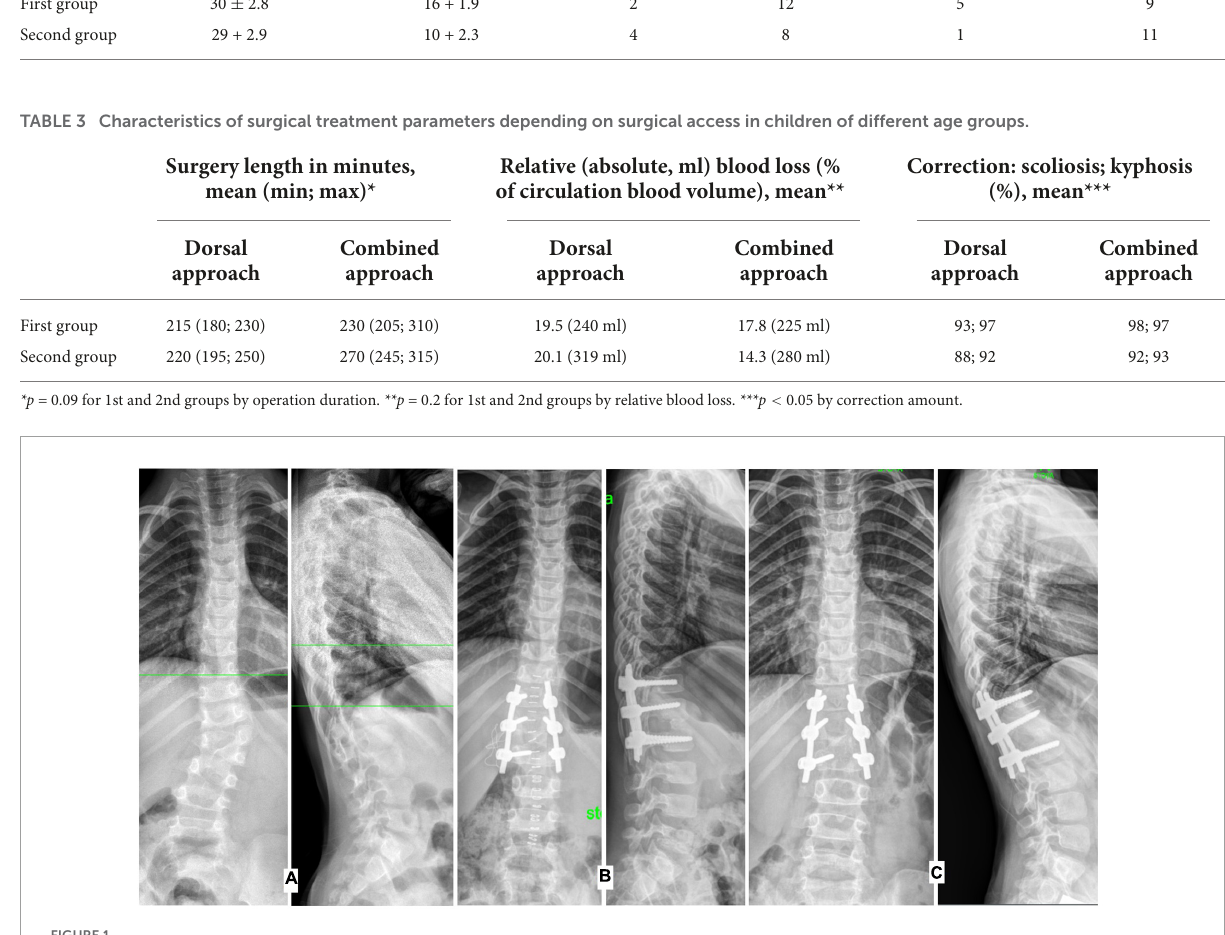
access was scoliosis—88% and kyphosis—92%, with combined, respectively: 90 and